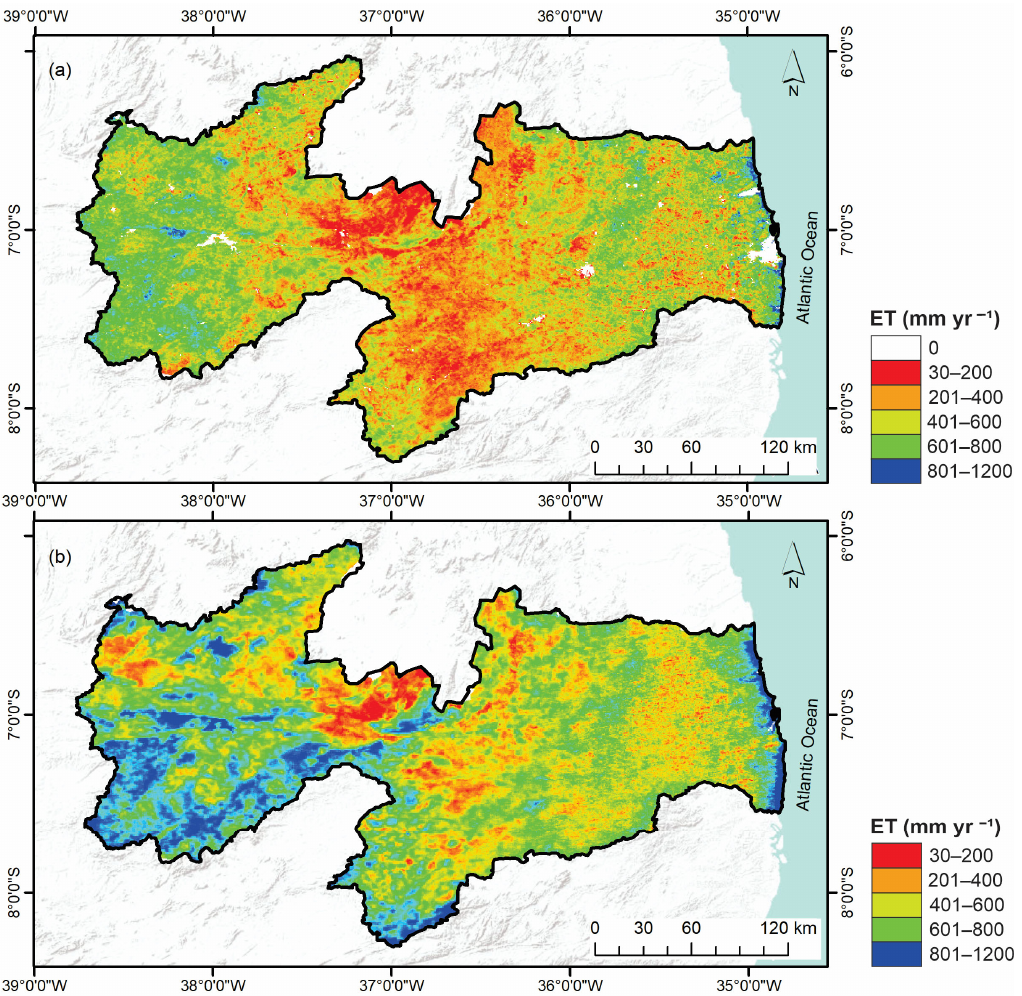
Figure 4. Annual ET derived from the products MOD16A2 ( a ) and SEBAL ( b ) for the state of Paraíba for 2013.